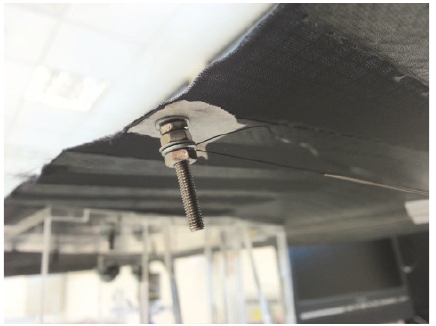
Figure 5: The trailing edge of the FMW is fitted with the tendon.